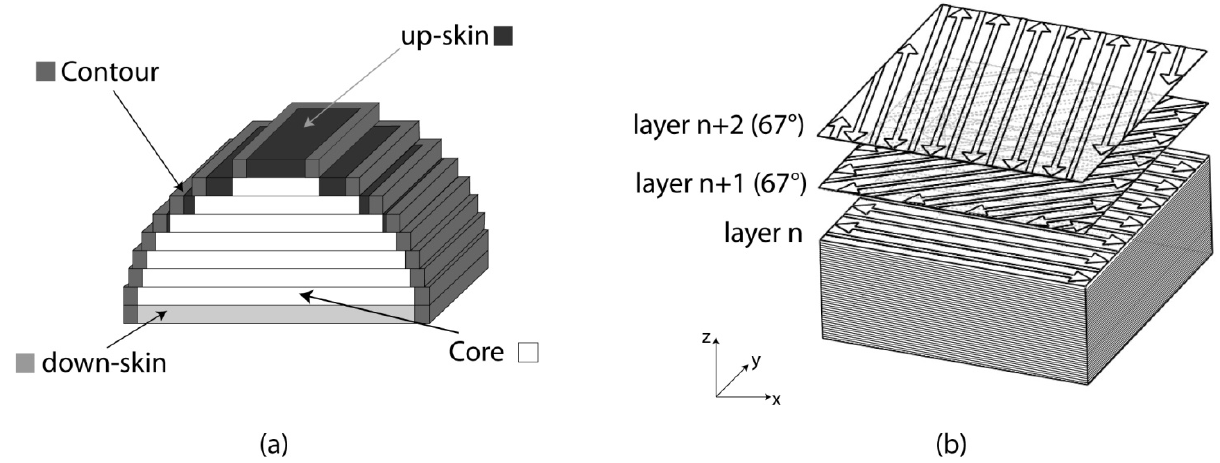
Figure 1. The scanning strategy employed in this work: ( a ) the parameters considered with different power and scanning speed; ( b ) the non-contour area of each layer is rotated of 67° in comparison to the previous